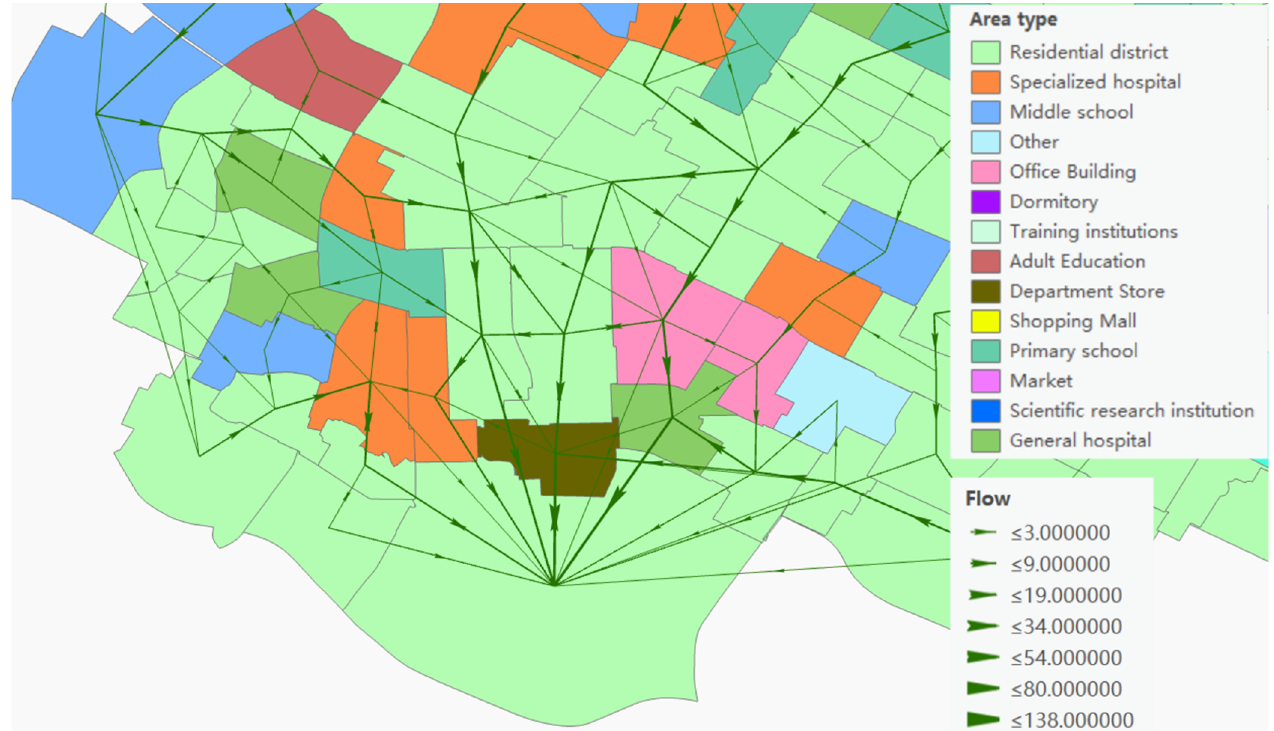
Figure 6. Outflow of single functional area to the whole city from 8:00 to 10:00 in the morning.